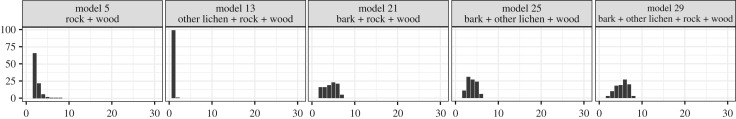
Results of evolutionary dead-end analyses based on comparison of 30 models of character change and 100 trees. The five models imposing different evolutionary dead-end scenarios that continuously (for the majority of trees) ranked among the five best models according to their AIC scores. Numbers behind this figure as well as plots for all additional models are given in the electronic supplementary material, table S3 and figure S123. x-axis: rank of model among the 30 tested models. y-axis: number of trees for which this model scored a particular rank.